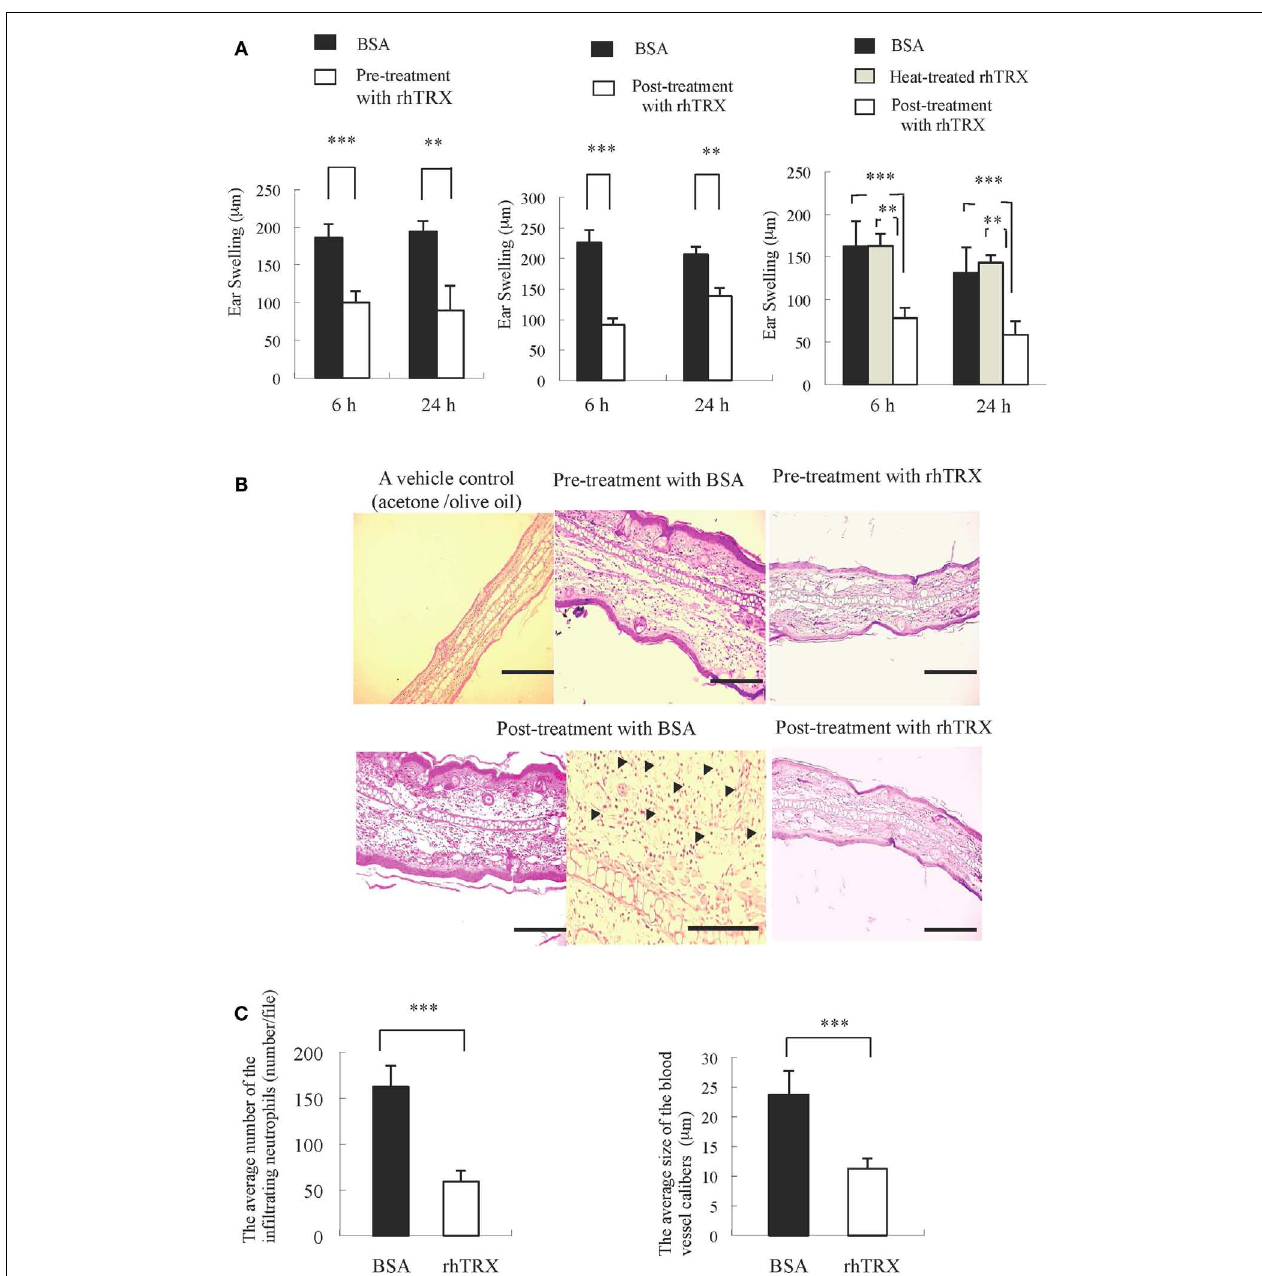
post-treatment in the rhTRX topical application group, compared with the control group. Acetone/olive oil was used as a vehicle control. Bars, 50 µ m.The infiltrating neutrophils were indicated by arrows (Bar, 100 µ m). (C) The average number of infiltrating neutrophil in the dermis and the dilatation of the capillary blood vessels were significantly reduced in the post-treatment rhTRX group, compared with the control group (*** P < 0.001). Data are expressed as the mean ± SD of five mice per group (Student t -test).